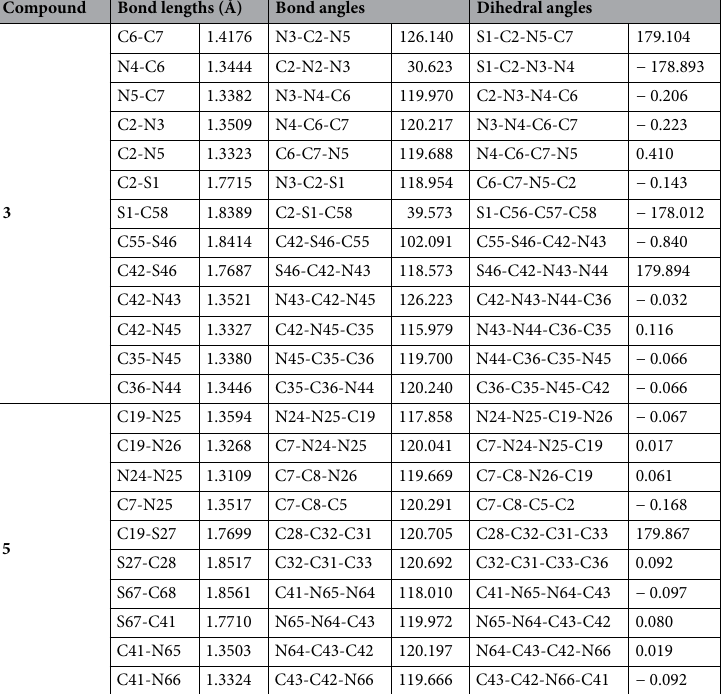
Table 1. Selected geometric bond lengths, bond angles, and, dihedral angles of the optimized 3 and 5 compounds using B3LYP/6-311G**.